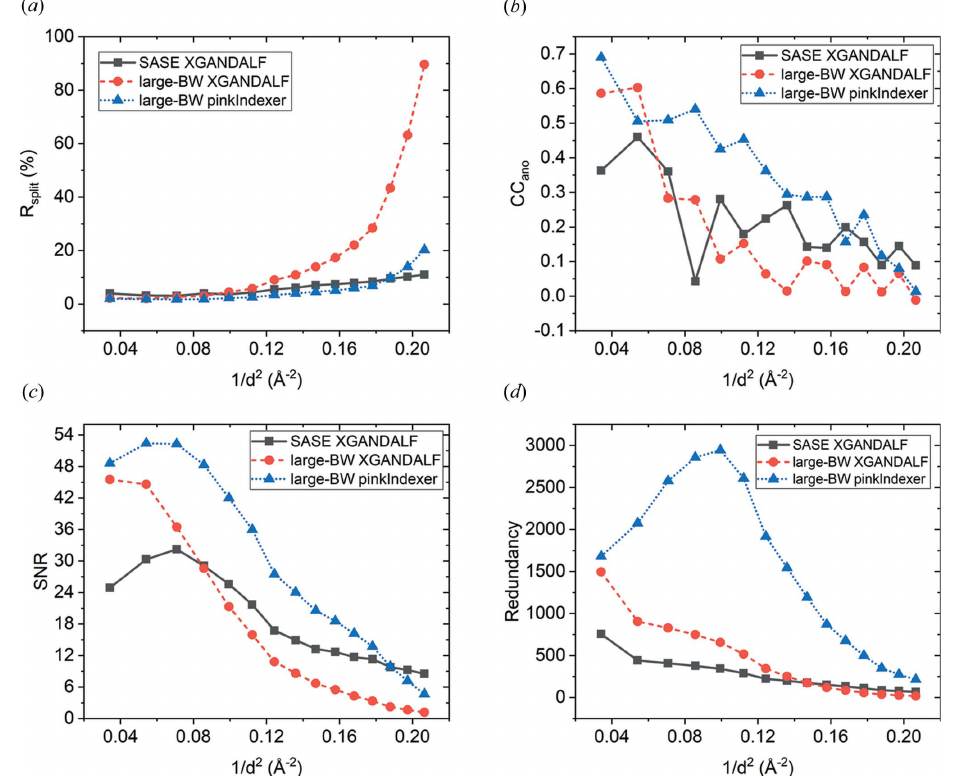
Figure 1 Comparison of data-quality indicators between the SASE and large-BW thaumatin data sets indexed by XGANDALF and pinkIndexer calculated with the same number of indexed images (102000) up to a resolution limit of 2.2 A˚ . ( a ) R split , ( b ) CC ano , ( c ) SNR and ( d ) redundancy of individual reflections as a function of